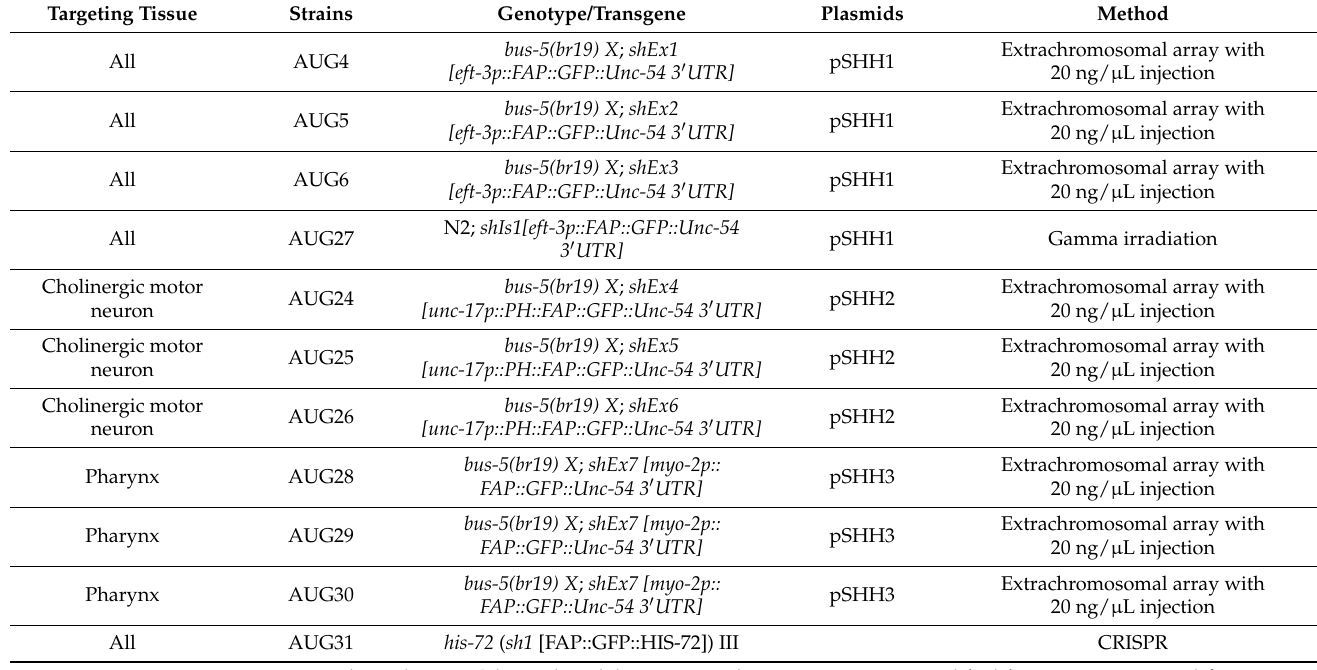
Table 1. FAP expressing strains used in this